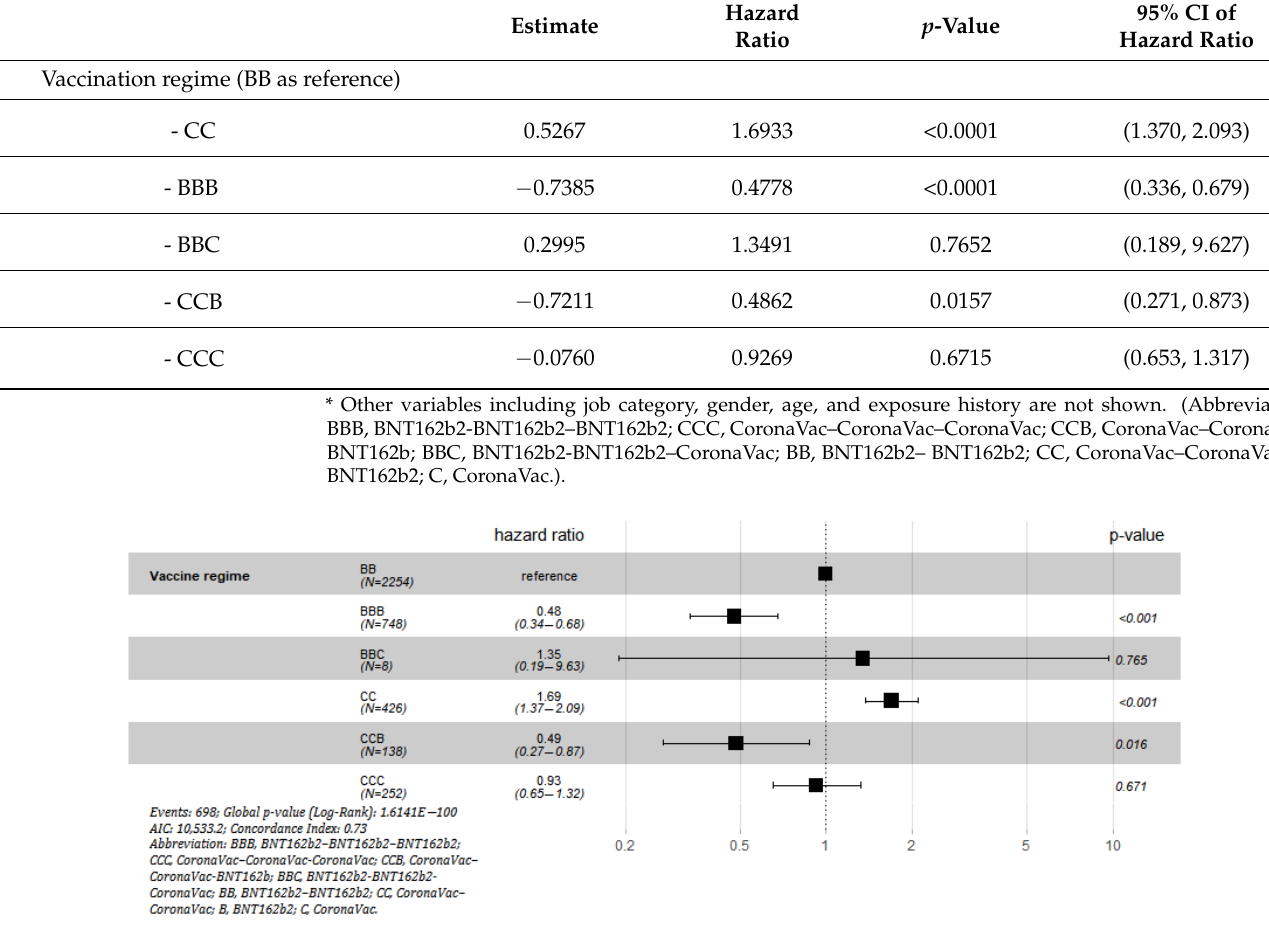
cination regime *.